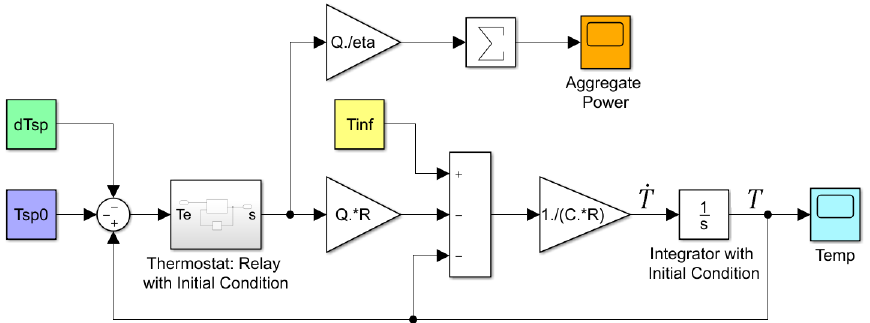
Figure 7. Block diagram of the aggregate thermostatically controlled load (TCL) system in Simulink. Table 2. System parameters adopted from Reference [14].